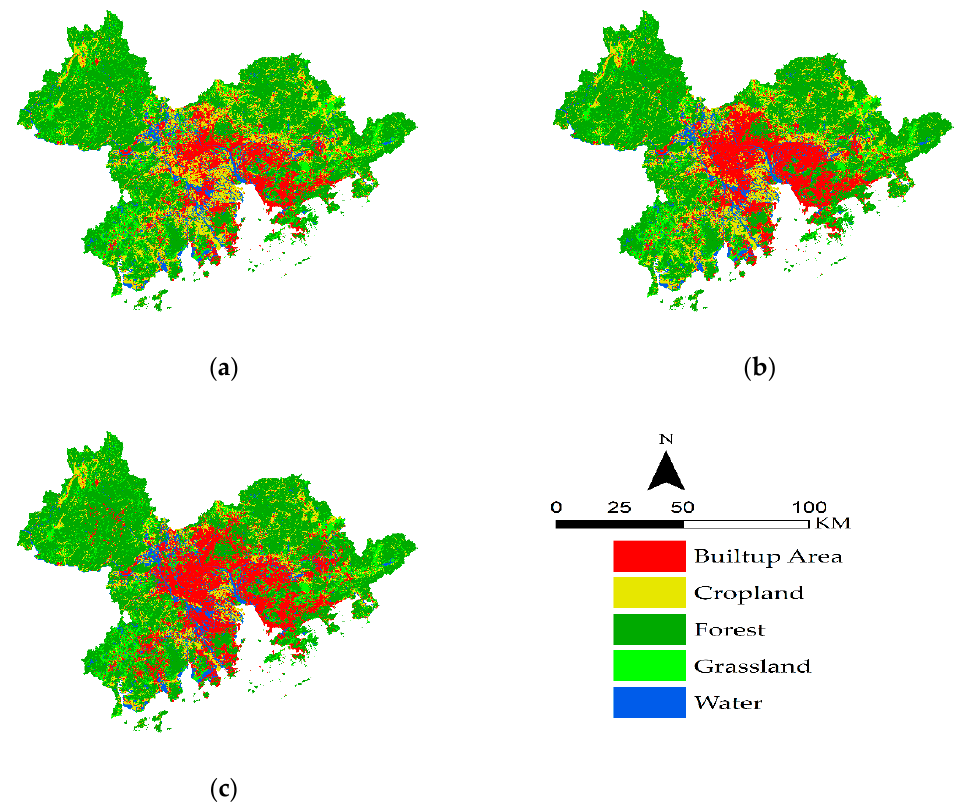
Figure 9 . LULC prediction; ( a ) 2030, ( b ) 2040, and ( c ) 2050. Figure 9. LULC prediction; ( a ) 2030, ( b ) 2040, and ( c ) 2050. Table 16. Predicted area statistics (2030, 2040 and 2050). Table 16. Predicted area statistics (2030, 2040 and